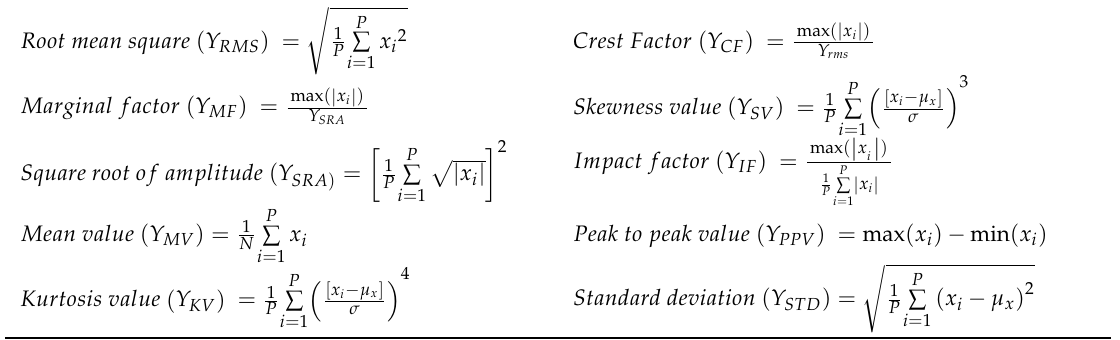
Table 2. Ten features used to train and test support vector machine